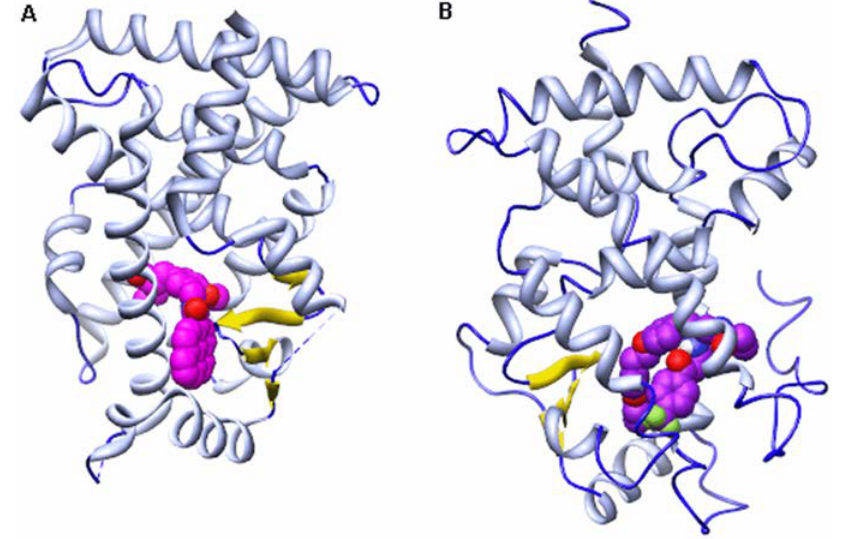
Figure 1. The overall structures of peroxisome proliferator activated receptor-α (PPAR-α)/ligand complexes. ( A ) PPAR-α/13M complex; and ( B ) PPAR-α/471 complex. PPAR-α backbone is shown in ribbon (Helix: white; Strand: yellow; Coil: blue). Agonist and antagonist are shown in sphere (Carbon atom: purple; Oxygen atom: red; Nitrogen atom: blue; Fluorine atom: